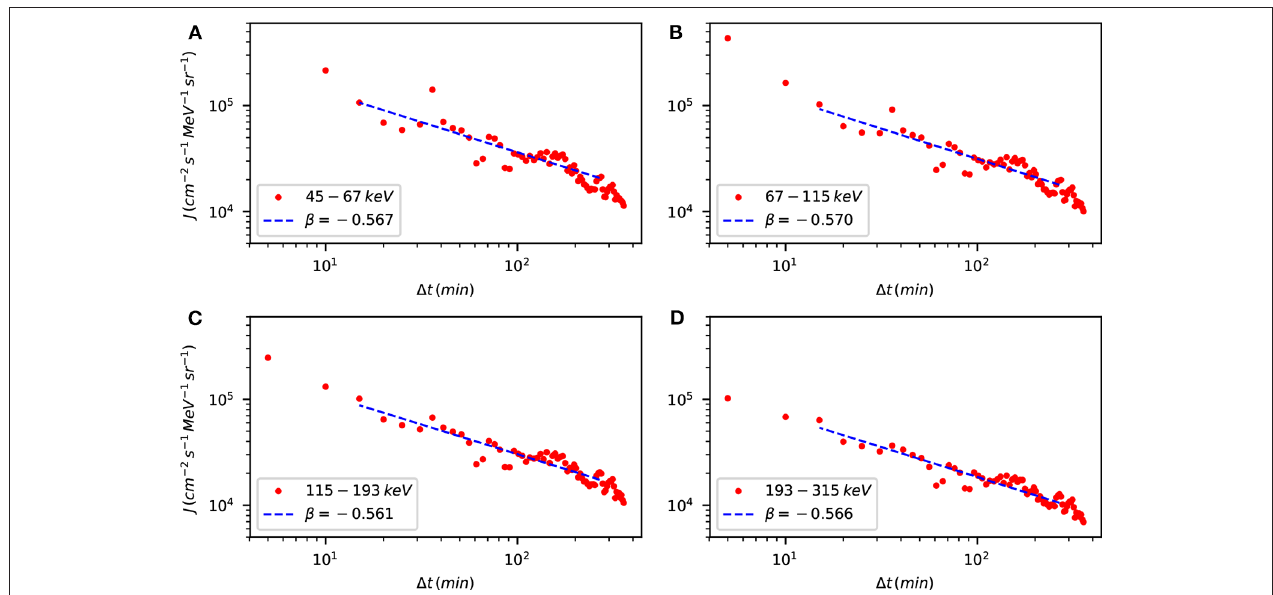
FIGURE 4 | Power-law fits (dashed lines) of the energetic particle fluxes (red dots) in several energy channels, see legends, for the shock crossing of 8 June 2000. The exponent of power-law fit is indicated in each legend. The panels correspond to the energy channels (A) 45–67 keV, (B) 67–115 keV, (C) 115–193, and (D) 193–315